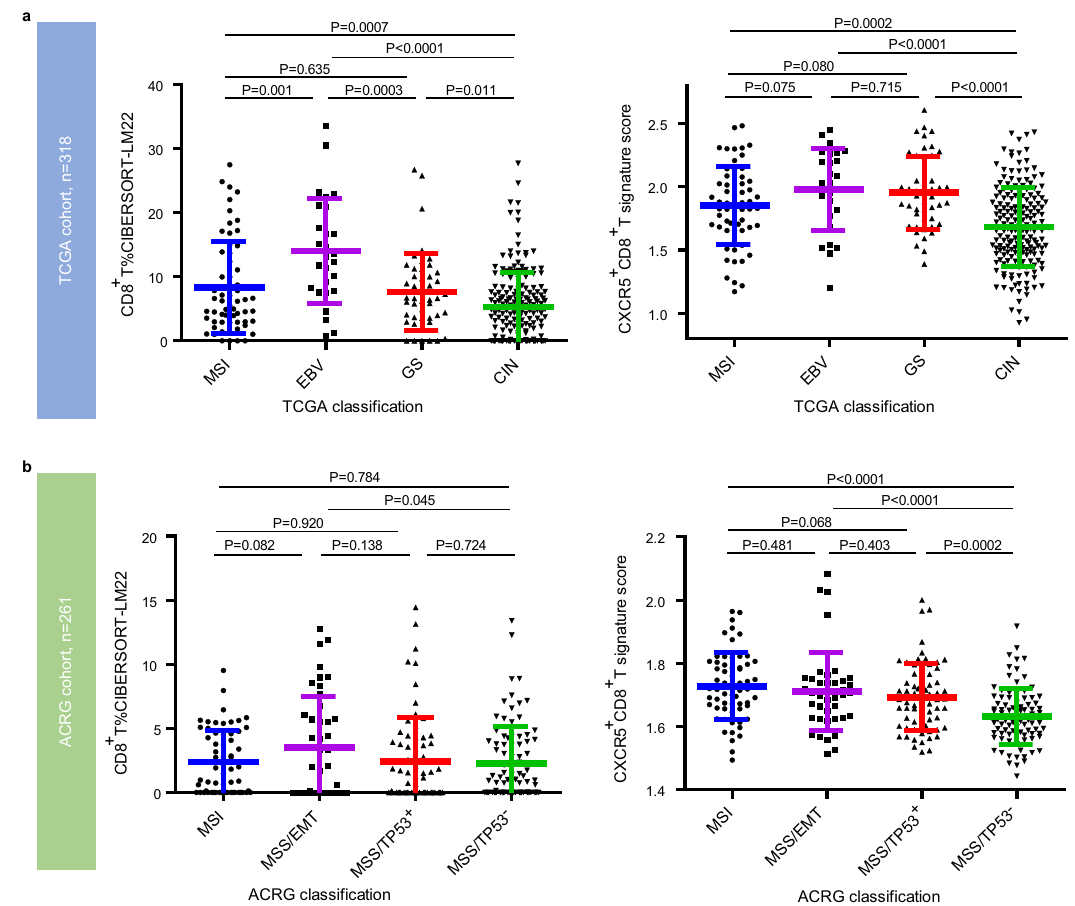
Fig. 4 Association of CXCR5 + CD8 + T with TCGA/ACRG classi fi cation. a CD8 + T%CIBERSORT-LM22 and CXCR5 + CD8 + T signature score in the MSI, EBV, GS, and CIN subgroups of the TCGA cohort (the TCGA classi fi cation, n = 318 patients with gastric cancer). Graph shows mean ± SD of n = 62 (MSI), n = 27 (EBV), n = 46 (GS), and n = 183 (CIN) individual patients, using statistical analysis by two-tailed unpaired t test. b CD8 + T%CIBERSORT-LM22 and CXCR5 + CD8 + T signature score in the MSI, MSS/EMT, MSS/TP53 + , and MSS/TP53 − subgroups of the ACRG cohort (the ACRG classi fi cation, n = 261 patients with gastric cancer). Graph shows mean ± SD of n = 61 (MSI), n = 43 (MSS/EMT), n = 68 (MSS/TP53 + ), and n = 89 (MSS/TP53 − ) individual patients, using statistical analysis by two-tailed unpaired t test. Source data are provided as a Source data fi le. TCGA The Cancer Genome Atlas, ACRG Asian Cancer Research Group, MSI micro-satellite unstable, EBV Epstein – Barr virus, GS genomically stable, CIN chromosomal instability, MSS micro- satellite stable, EMT mesenchymal-like type, TP53 tumor protein